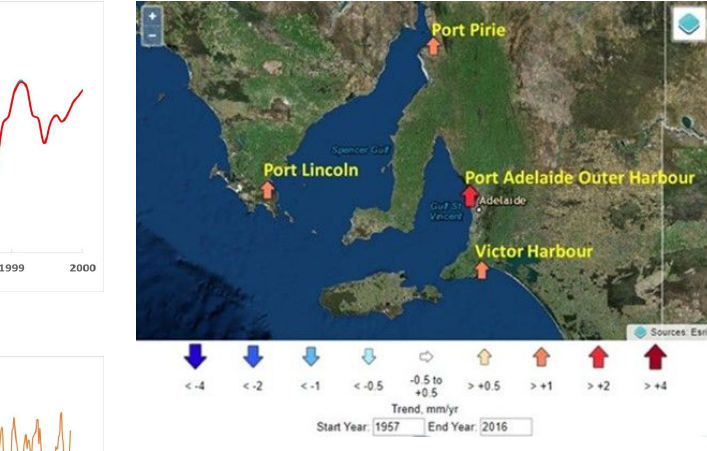
Figure 15: Tide gauges of South Australia with at least 70% of data over the time window 1957 to 2016. Image modified after PSMSL.